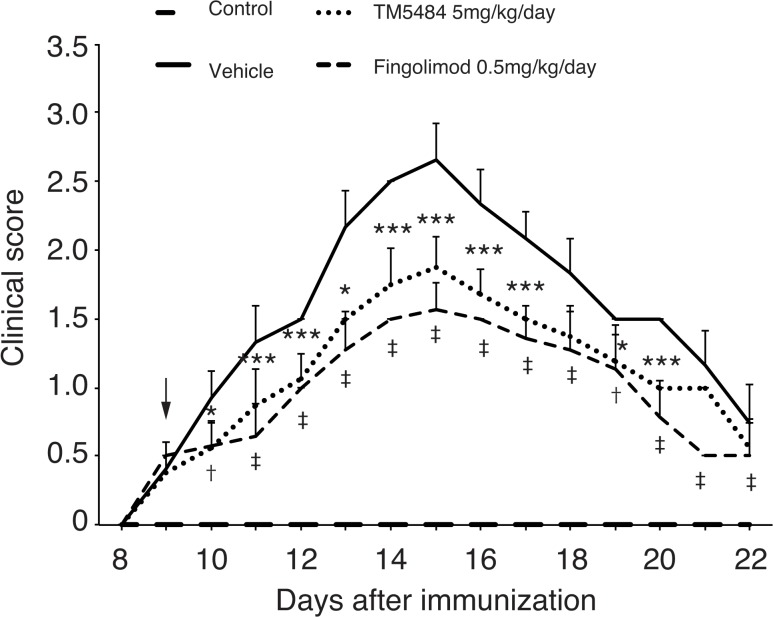
Clinical score in the rat MS model.Rats were injected with myelin basic protein69-88 peptide in an equal volume of complete Freund’s adjuvant. Administration of TM5484 (5 mg/kg/d) from the onset of symptoms significantly attenuated the paralysis score in EAE-treated rats (P<0.001 vs. vehicle at dpi. 15). Fingolimod (0.5 mg/kg) also reduced the paralysis score to a level similar to TM5484 (P<0.001 vs. vehicle at dpi. 15). The peak of the disease was selected to analyze the paralysis score as all animals, including vehicle, had an almost complete recovery by day 22. Data are shown as the means and corresponding SD. *P<0.05 or ***P<0.001 Vehicle vs TM5484, †P < 0.01, ‡P < 0.001 Vehicle vs Fingolimod by 2-way ANOVA and Bonferroni test, n = 6–8.